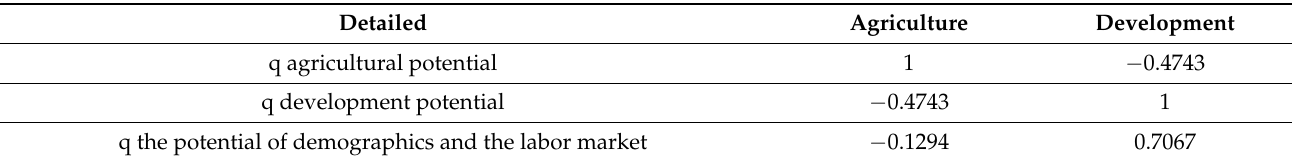
Table 6. Correlation between measures of development potential and agriculture, and socio-economic variables in voivod- ships of Poland (Pearson’s